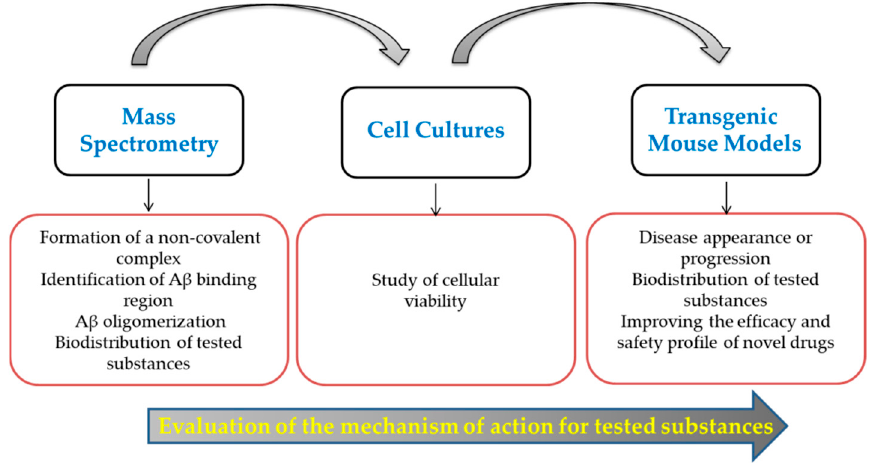
Figure 5. Workflow for the evaluation of the mechanism of action for potential inhibitors of A β oligomerization.